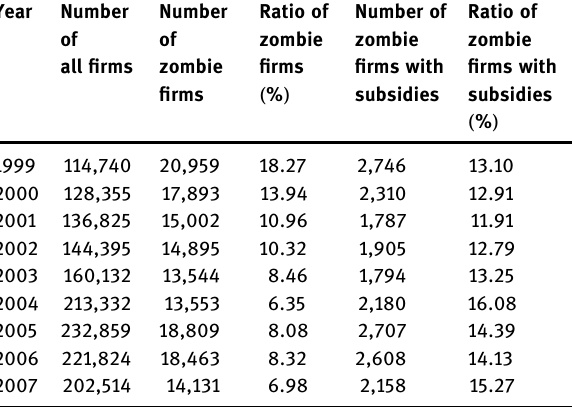
Data source: Chinese industrial fi rm